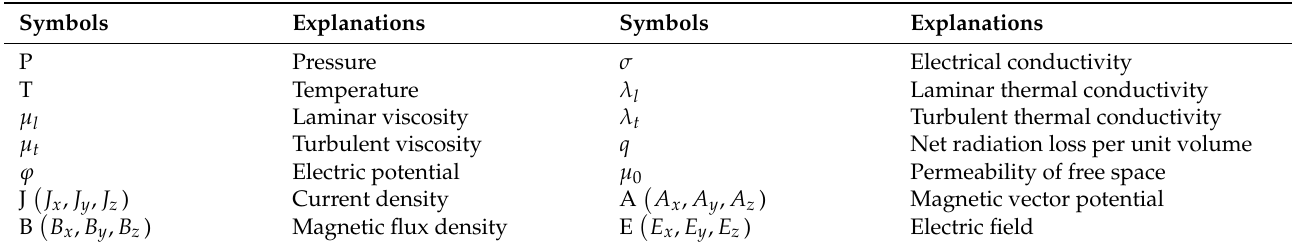
Table 2. Explanations of the symbols in the